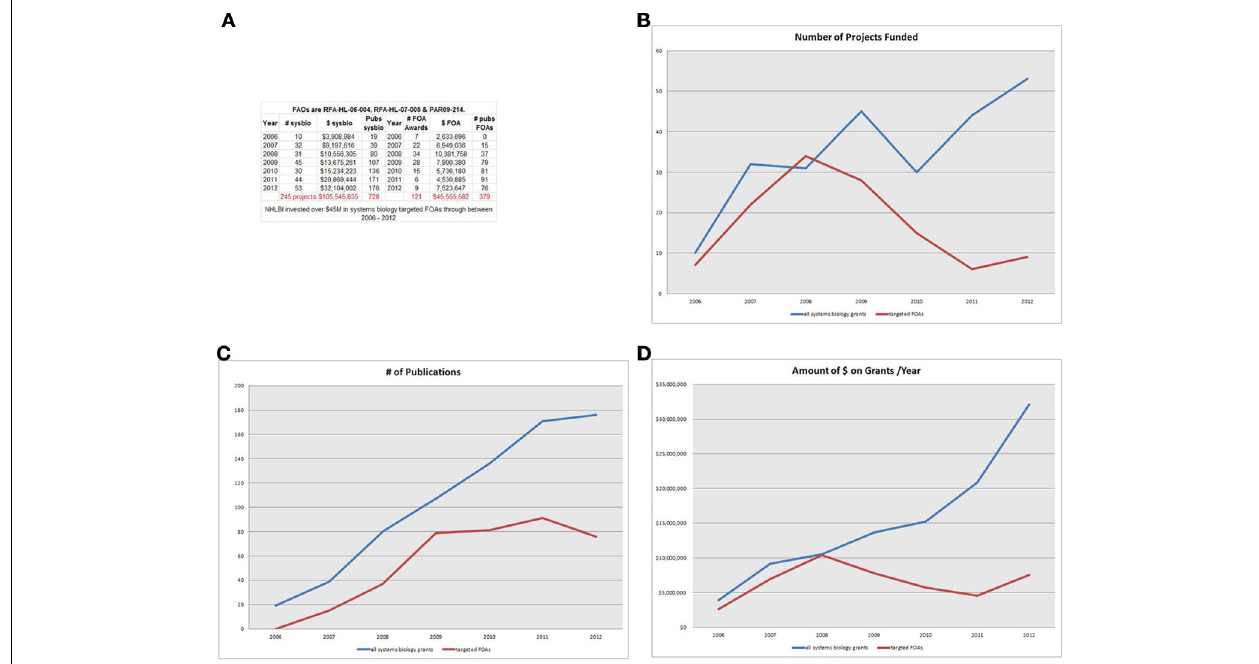
FIGURE 1 | (A) NHLBI investment-Legend-NHLBI invested over $45M in systems biology targeted FOAs through between 2006 and 2012. (B) # of projects-Legend-For the first three years, the targeted systems biology FOAs make up most of the awards in the NHLBI portfolio. But as RFA funding ends, the number of awards self-identifying as systems biology projects increases (2011 and beyond). (C) # of